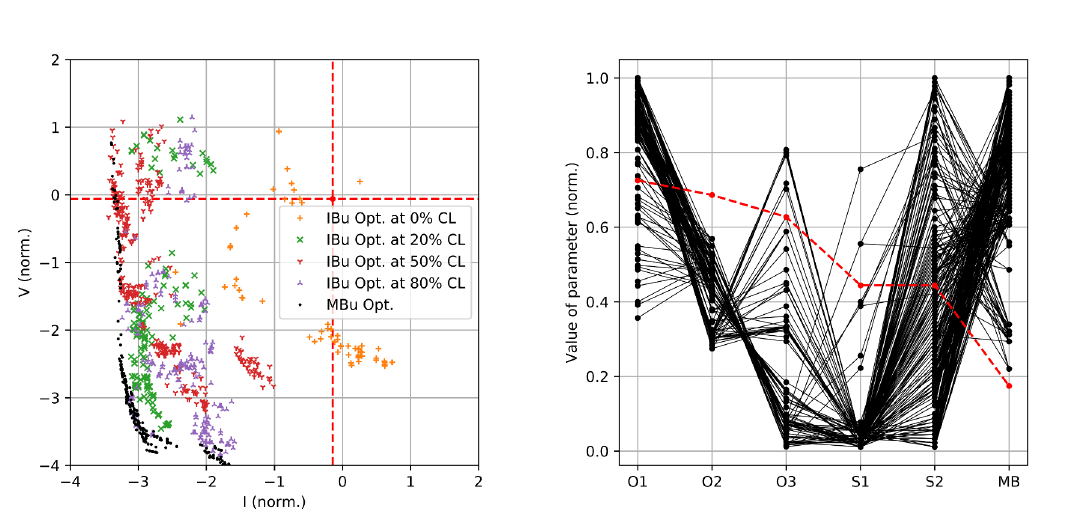
Figure 3: Results of the MBu optimization